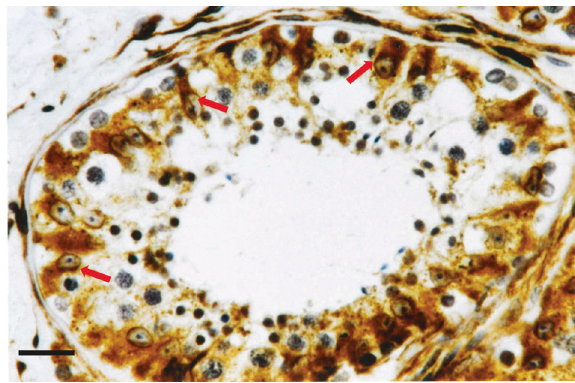
Fig. 2 Immunohistochemical localization of SPATA2 at the Sertoli cell level. The expression of SPATA2 is highlighted as a brown color that is localized in correspondence with the cytoplasm of Sertoli cells (indicated by arrows) which are easily recognizable by their elongated and branched shape and by an ovoid nucleus with the evident nucleolus. No positivity was observed in any cell of the spermatogenic germline. Scale bar = 20 μ